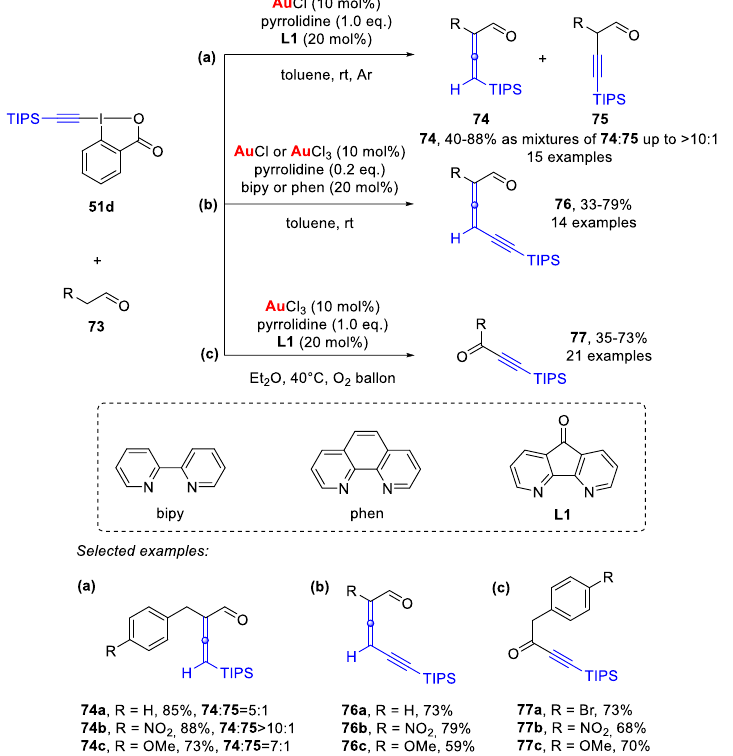
Scheme 16. Gold/pyrrolidine catalyzed α -vinylidenation reaction of aldehydes 73 with the use of TIPS-EBX 51d . See explanation of reactions ( a – c ) in the text. Selected examples of products obtained in the reactions ( a – c ) are shown at the bottom of the scheme. Atom economical gold-catalyzed reactions with the use of EBX were reported re- cently. Au-catalyzed 1,2-oxyalkynylation of N -allenamides 78 with ethynylbenziodoxoles 51 gives direct access to valuable 1,3-enynes 79 under mild conditions (Scheme 17a) [94].